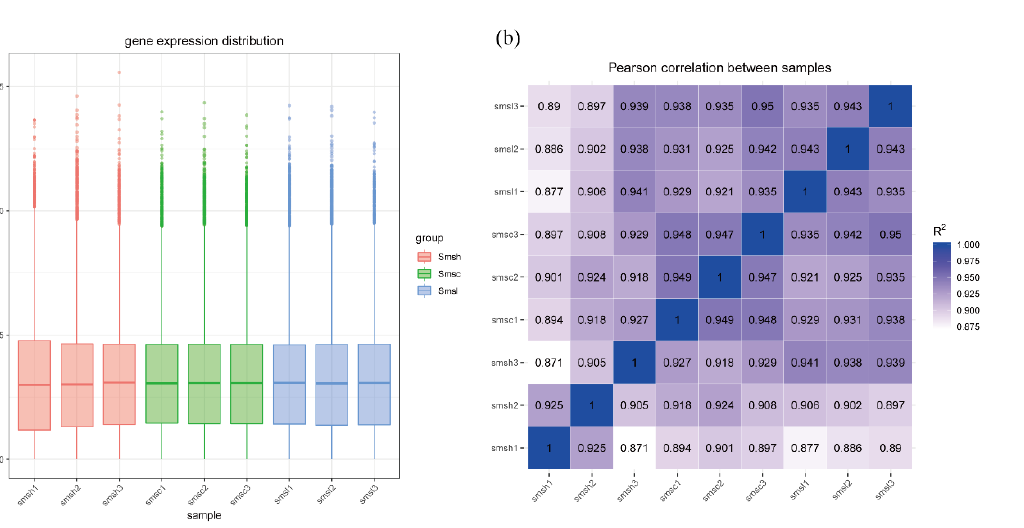
Figure 2. Volcano plot of DEGs in different salinity comparison groups. (a) Smsh versus Smsc vol- cano plot; (b) Smsh versus Smsl volcano plot; and (c) Smsl versus Smsc volcano plot. As shown by the Venn diagram (Figure 3), there were 68 significantly differentially expressed genes in Smsh compared with Smsl, 82 and 40 differentially expressed genes in Smsh and Smsl compared with Smsh vs. Smsl. In addition, a total of three differential genes were significantly expressed in the three groups, namely, phosphatidylinositol 3- kinase regulatory subunit 6b (pik3r6b), cytoplasmic phospholipase A2- γ -like gene (cPLA2γ -like), and WD repeat and SOCS box containing 1 (WSB1). As shown in Table 4, the expression of their differential genes also differed according to salinity stress, with pik3r6b, cPLA2γ -like, and wsb1 all significantly differentially expressed in the high-salt group.